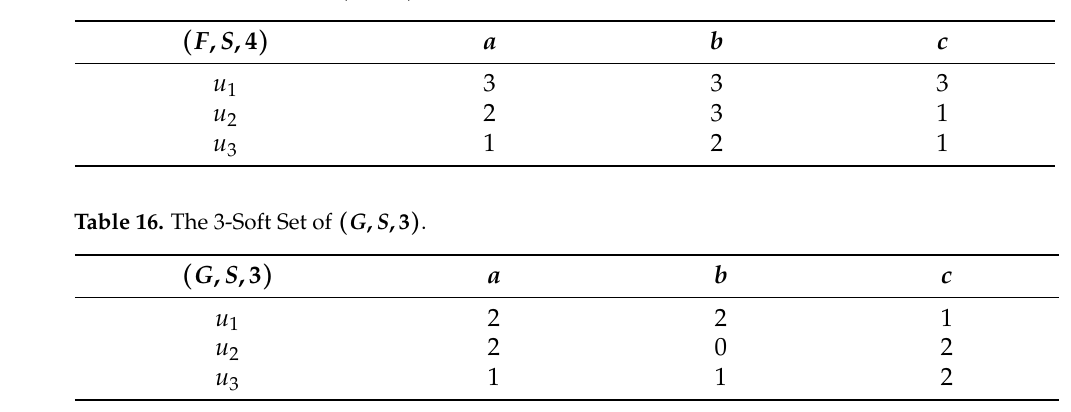
Table 15. The 4-Soft Set of ( F , S ,4 ) .